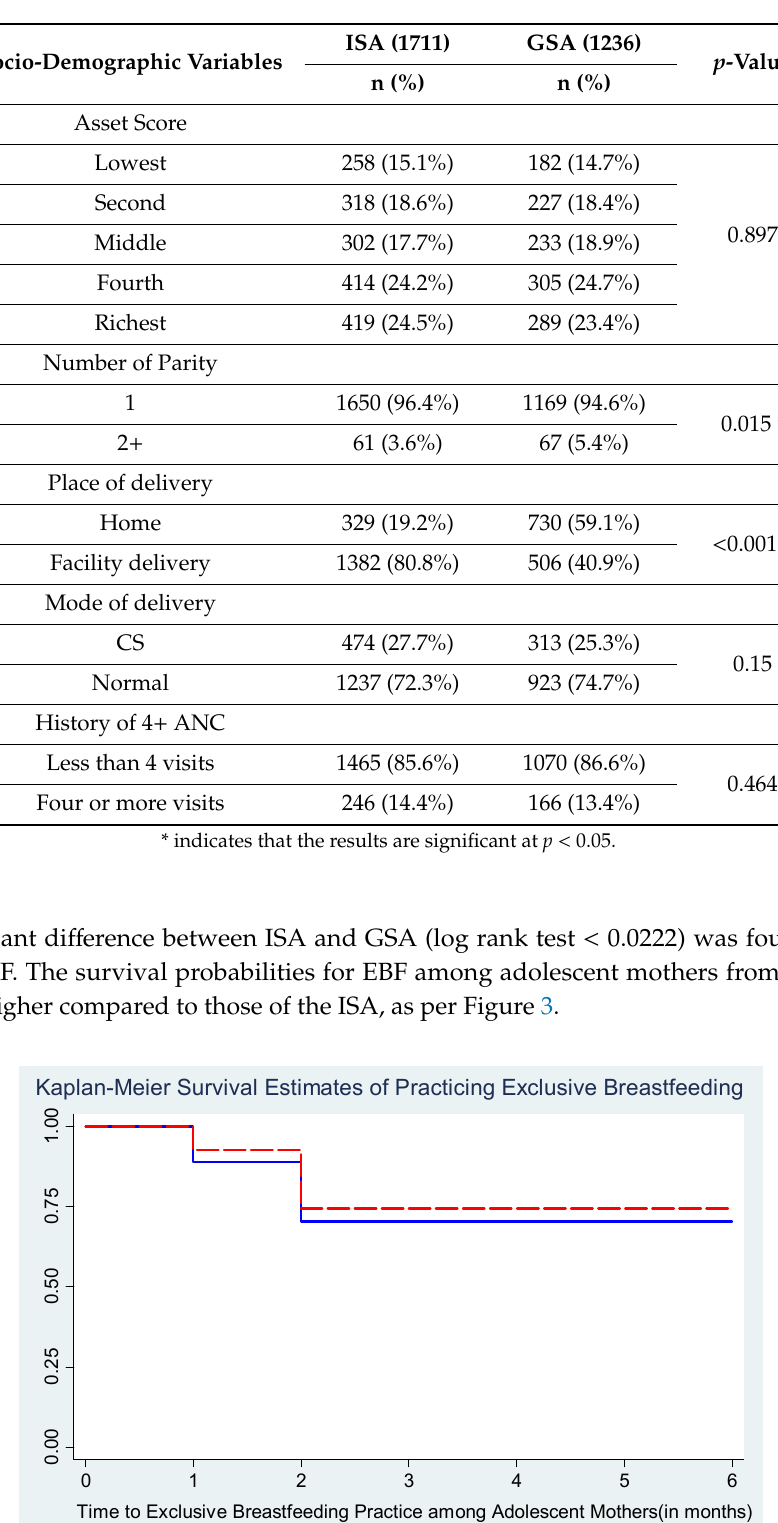
Table 2. Factors associated with exclusive breastfeeding: results from bivariate and multivariate analysis.